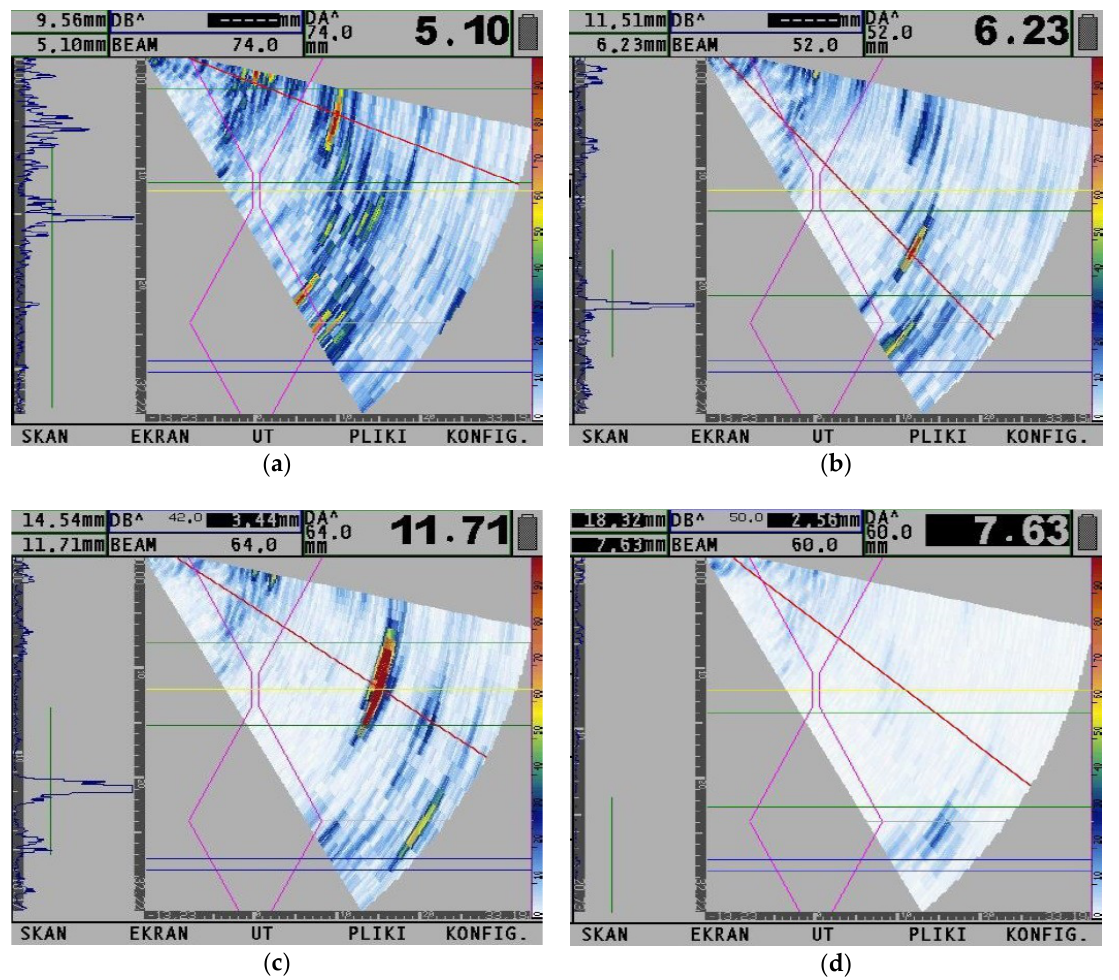
Figure 8. Results of the ultrasonic test (UT) by phased array (PA) technology: ( a ) beginning area of specimen SW; ( b ) finishing are of specimen SW; ( c ) lack of fusion area in specimen SA and ( d ) the area without imperfections in specimen SA.